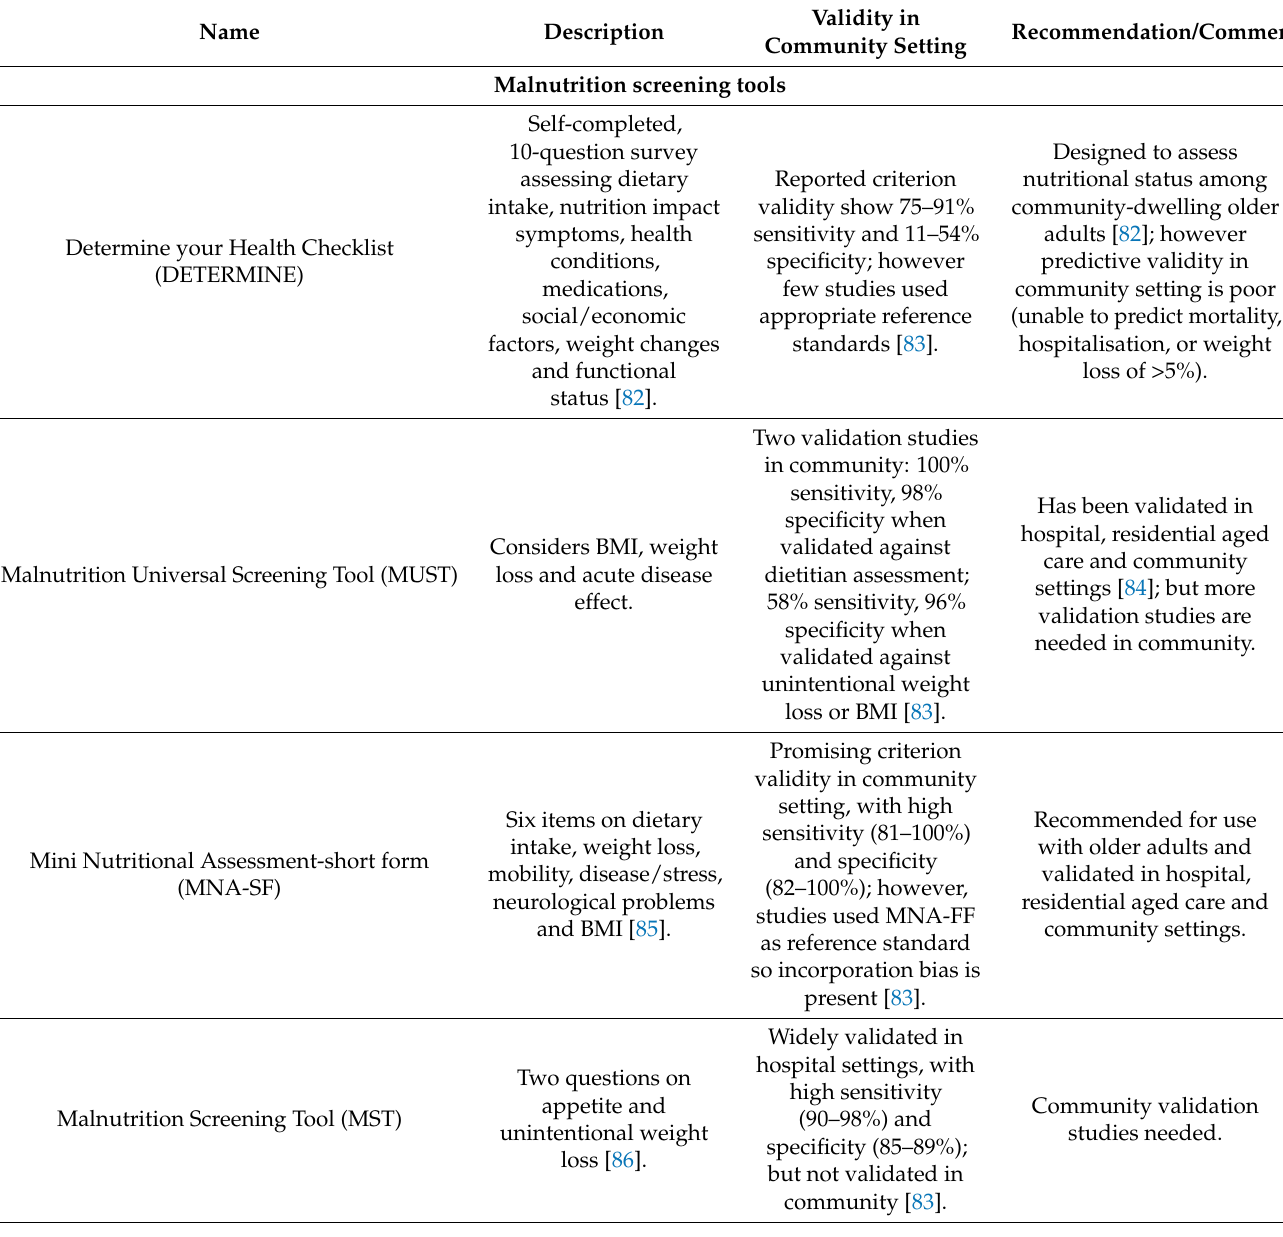
Table 2. Malnutrition, frailty and sarcopenia screening tools—validity in community